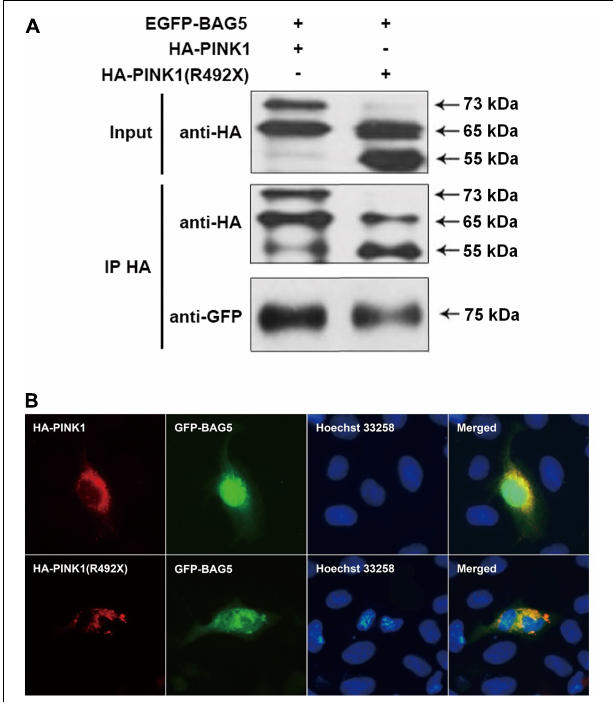
FIGURE 2 | BAG5 interacts with R492X mutated PINK1 protein. (A) BAG5 interacts with PINK1 and R492X mutated PINK1 protein. We performed co-IP assays using HEK293 cells expressing GFP-BAG5 and HA-PINK1 or HA-PINK1 R492X . Cell lysates were subjected to co-IP with rabbit polyclonal anti-HA tag antibody. The IP and input lysates were analyzed by immunoblotting with mouse monoclonal anti-HA tag antibodies. The results showed that BAG5 interacts with both wild type PINK1 and R492X mutated PINK1 protein. (B) Co-localization of GFP-BAG5 and HA-PINK1 R492X . HEK293 cells were transfected with EGFP-BAG5 and HA-PINK1 or HA-PINK1 R492X . Images show regional co-localization of BAG5 with R492X mutated PINK1